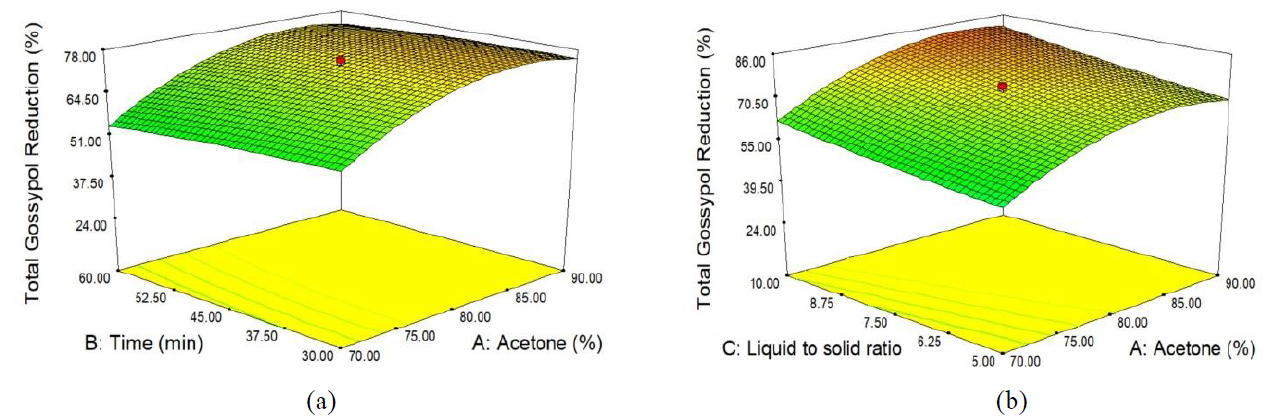
Figure 8. ( a ) 3D surface plot between time of extraction and acetone % ( b ) 3D surface plot between LSR and acetone %.